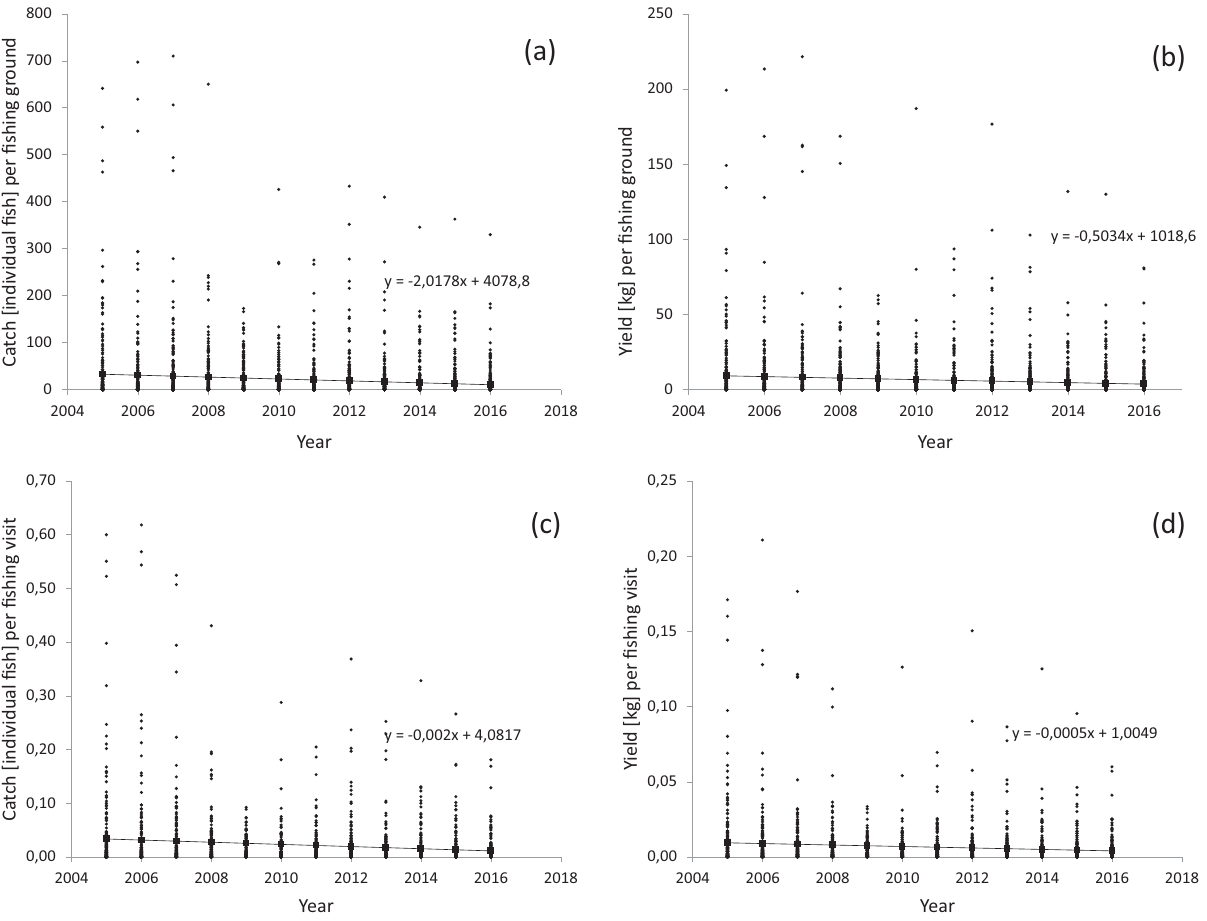
Fig. 2. Annual catch and yield of perch per fi shing ground (a, b) and mean catch and yield per fi shing visit by fi shing ground (c, d). Each dot shows an observed value for one fi shing